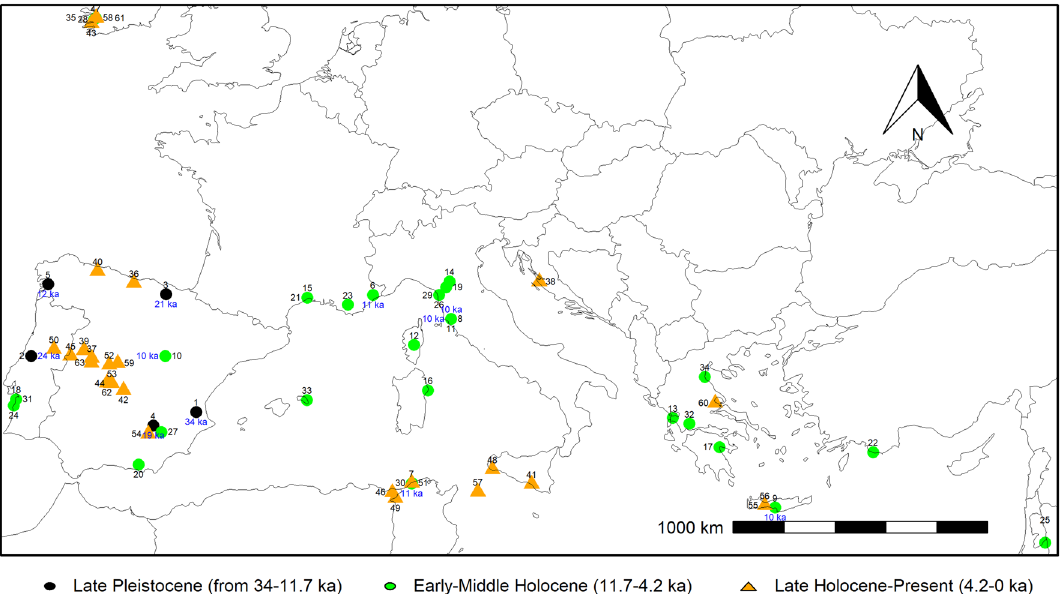
Figure 5. Map of the pollen sites in the Mediterranean region with Arbutus/Arbutus unedo records. Data retrieved from the Neotoma Paleoecology Database 37 . The site number 2 is a charcoal remain 46 . According to the oldest age of the record, the following site labeling was used: Late Pleistocene (from 34–11.7 ka), black-filled circles, Early-Middle Holocene (11.7–4.2 ka), green-filled circles, and Late Holocene-Present (4.2–0 ka), orange- filled triangles. The sites were numbered according to Supplementary Table S3, and the records age above 10 ka, for clarity, were displayed in deep blue. Equal-area projection EPSG:3035. The map was made using the sf 1.0–3 and the terra 1.4–14 (https:// rspat ial. org/ terra/) packages in R 4.1.0 32,33